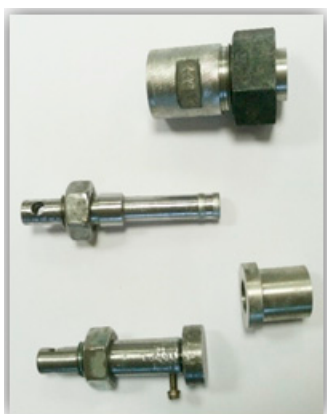
Figure A2. Metal fixtures and sleeves (right) used in the structural modification (pelletization) of carbonized refuse-derived fuel (CRDF).